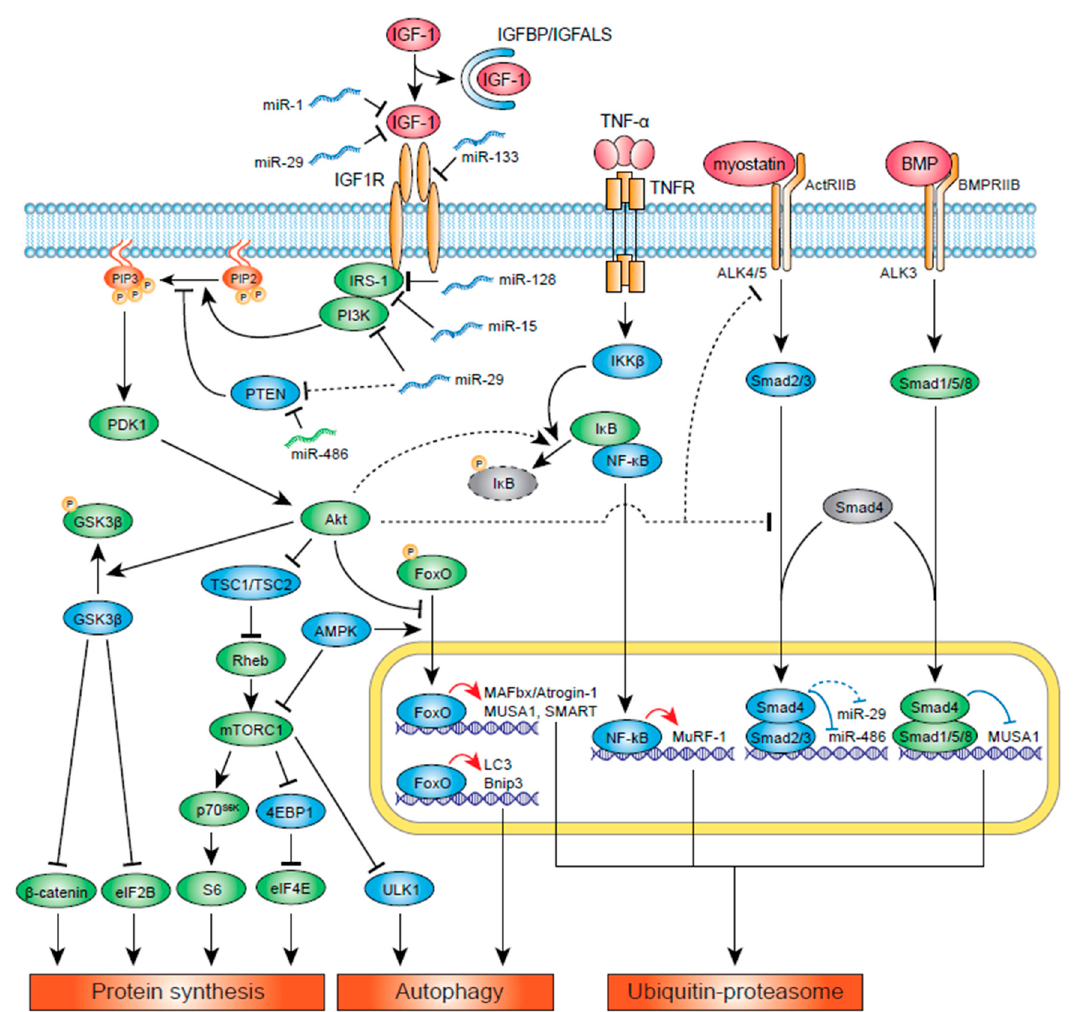
Figure 1. IGF-1 signaling pathways. In the figure, the signaling molecules and miRNAs that activate protein synthesis and/or inhibit protein degradation are shown in green, while the ones that inhibit protein synthesis and/or activate protein degradation are shown in blue. The majority of IGF-1 in the body are bound to IGFBP and IGFALS, and its activity is suppressed. Once IGF-1 binds to IGF-1R, IRS-1 and PI3K are recruited and activated. PI3K converts PIP2 to PIP3, which activates PDK1 and Akt. Akt activates protein synthesis via activation of ribosomal protein S6 and the translation initiation factor eIF4E downstream of mTORC1, and activation of β -catenin and eIF2B downstream of GSK3 β . Akt can suppress UPS activity via inhibition of FoxO-mediated transcription of E3 ubiquitin ligases MAFbx/Atrogin-1, MUSA1, and SMART. MuRF1 expression is induced by cytokines such as TNF- α via NF- κ B pathway. Akt could phosphorylate I κΒ and activate the NF- κΒ pathway, although it has not been shown in skeletal muscle and multiple studies have shown IGF-1 activation does not alter MuRF1 expression. Myostatin and BMP signaling compete against each other for their usage of Smad4. Activation of myostatin inhibits BMP-mediated Smad1/5/8 translocation to the nucleus, thus inhibiting MUSA1-mediated UPS activity. Akt can also downregulate ActRIIB and inhibit ALK4/5 via unknown mechanisms. Although it has not been shown in skeletal muscle, Akt can interact directly with unphosphorylated Smad3 to sequester it outside the nucleus. Several